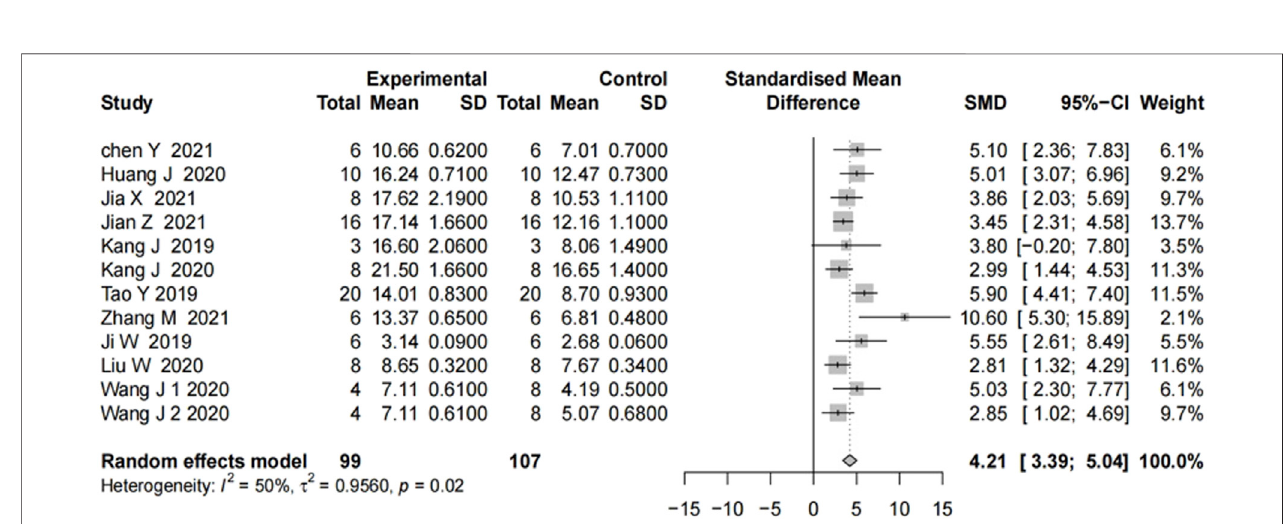
FIGURE 2 | The forest plot shows the effect of MIR-modi fi ed exosome therapy on motor function on the 28 th days after spinal cord injury. A positive SMD represents an improvement in the sports score.